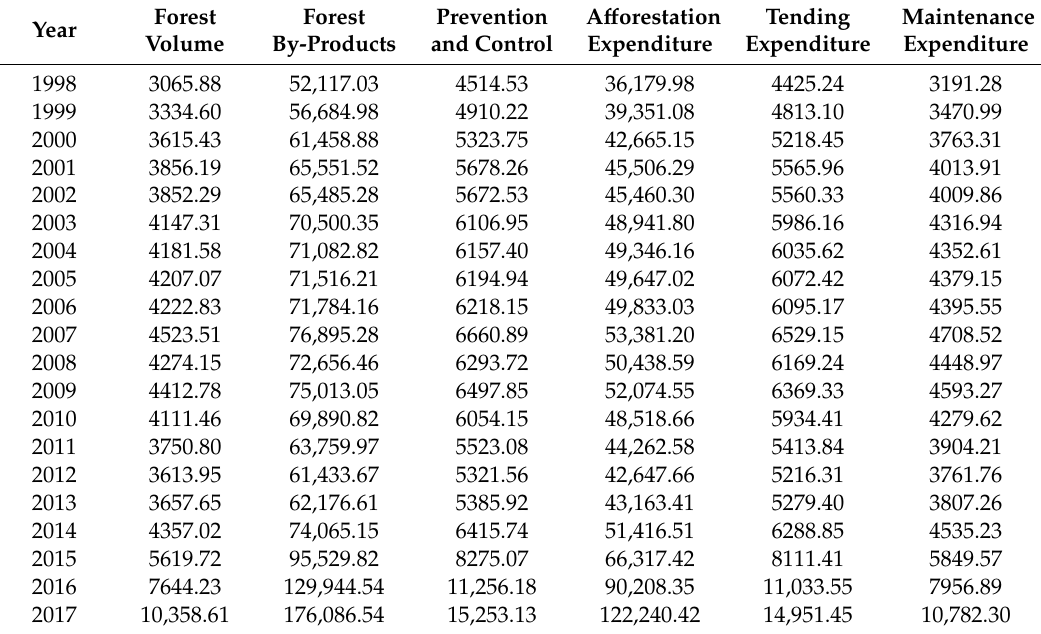
Table A5. Direct economic losses from disease in Mainland China from 1998 to 2017 (Tertiary indicator) / 10 4